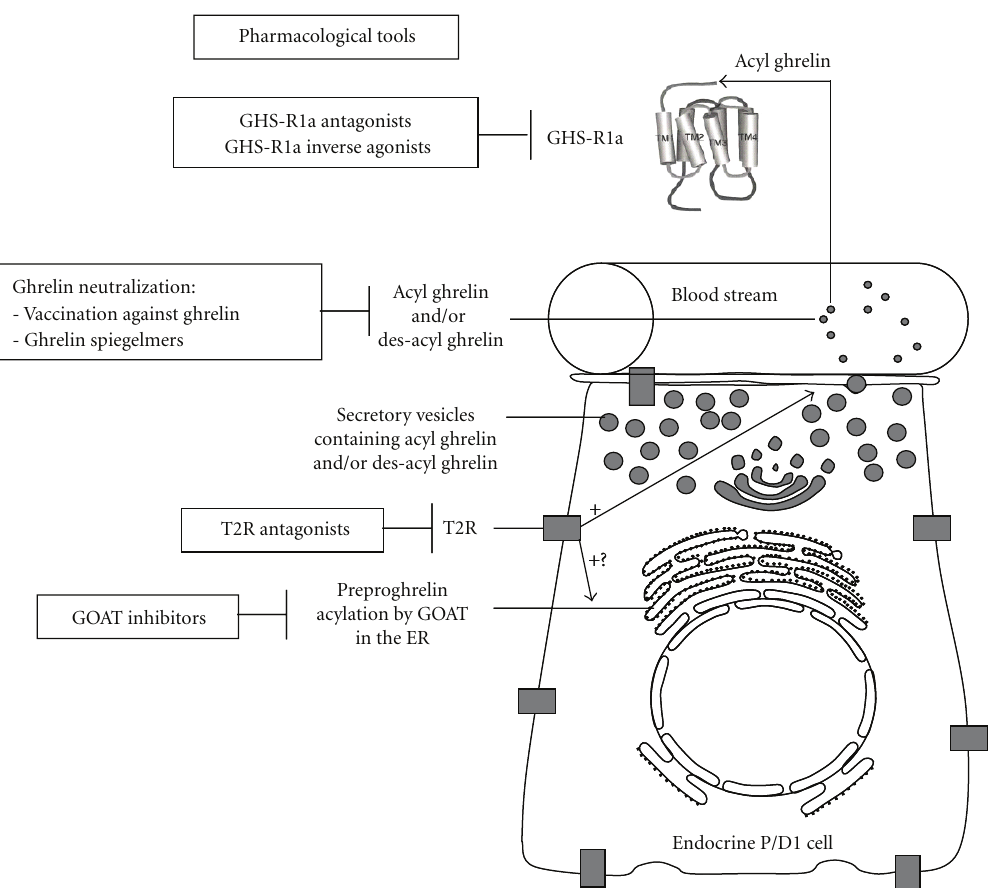
Figure 1: Synthesis, processing, and release of ghrelin by the human endocrine stomach P/D1 cells. Synthesis of ghrelin and acylation by GOAT occur in the endoplasmic reticulum (ER). Both acyl and des-acyl ghrelin are then secreted into the blood stream by fusion of secretory vesicles with the plasma membrane. Ghrelin secretion and/or acylation are upregulated following T2R activation. After secretion of acyl and/or des-acyl ghrelin, acyl ghrelin binds to specific GHS-R1a receptors. Pharmacological tools tried or currently developed are indicated and targeted GOAT, T2R, ghrelin, and